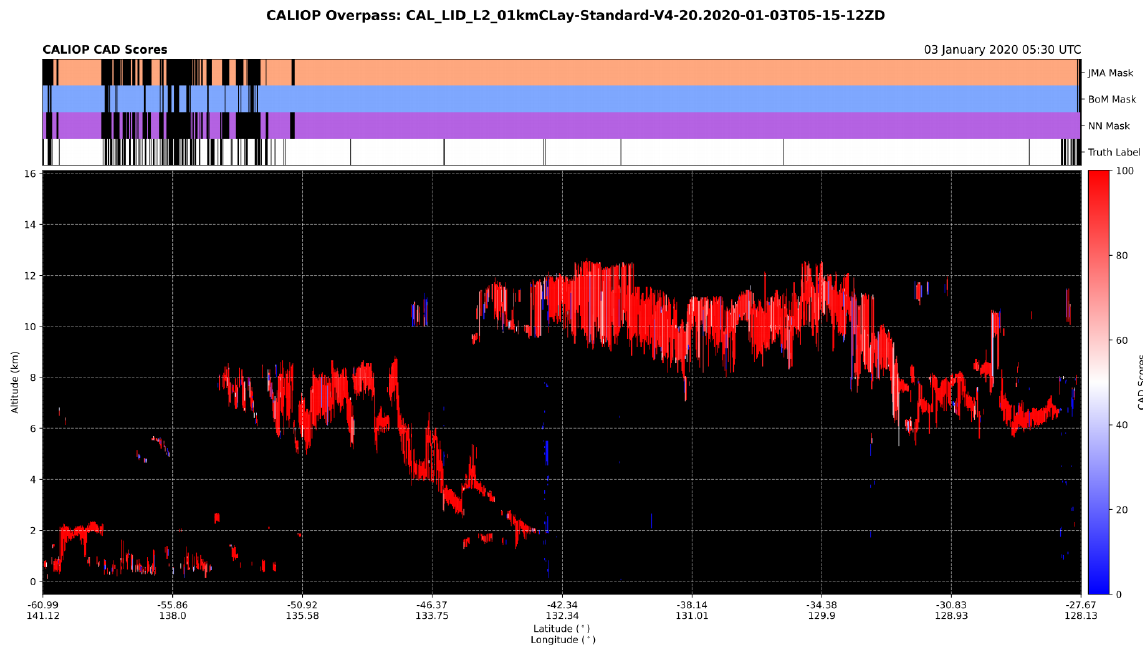
Figure 4. The CAD scores from a collocated CALIOP overpass are plotted along with the cloud masks used in this study and the truth label used for training the NN algorithms. Table 2. Summary of KSS, TPR and FPR for various angular geometries, surface types and air masses. Note that (cid:50) sat is the satellite zenith